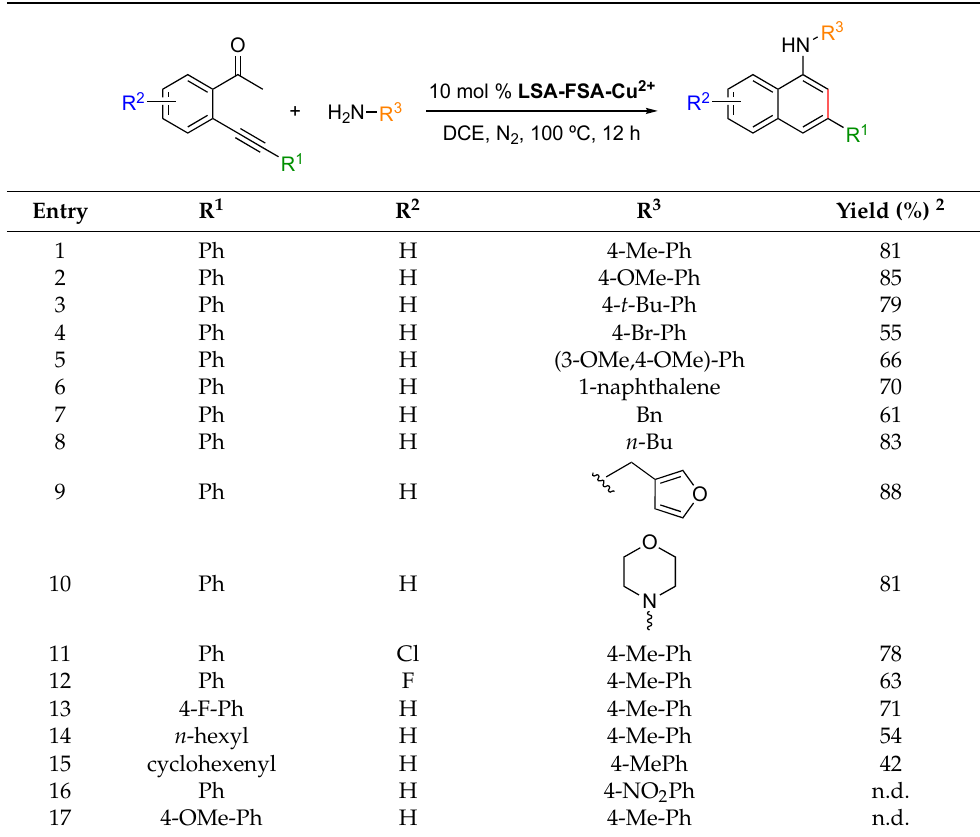
Table 6. LSA-FAS-Cu 2+ -catalyzed synthesis of aminonaphthalene derivatives [34] 1 .